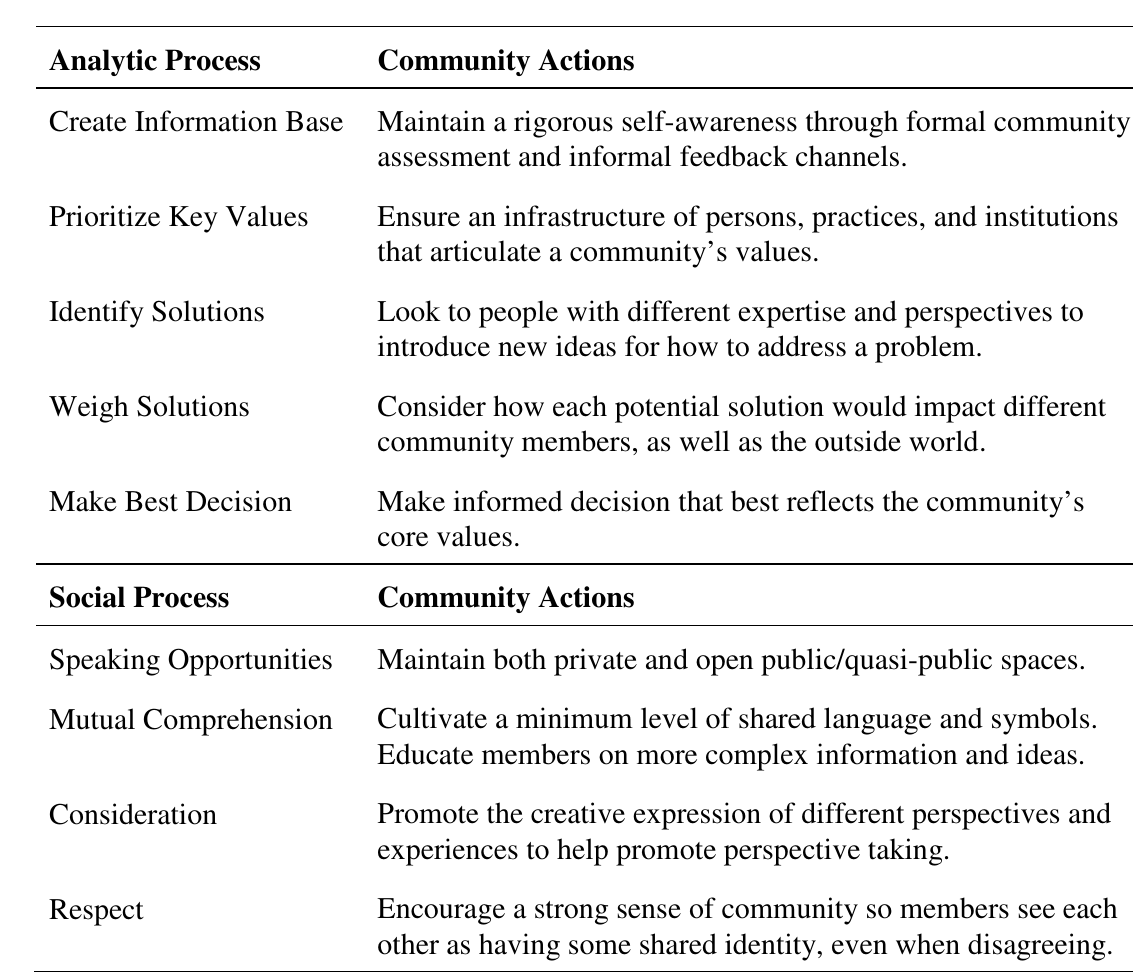
Table 7 Key Features of a Deliberative